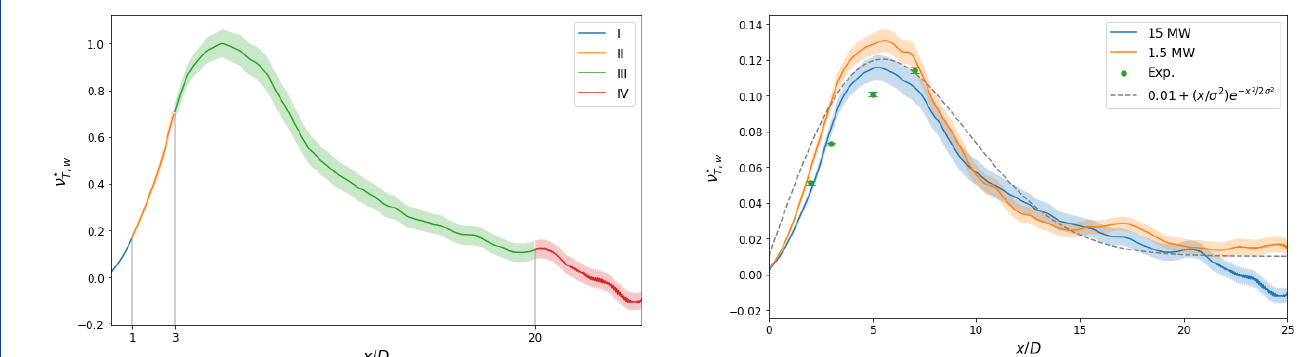
Figure 5. Normalized wake eddy viscosity for the aligned 15MW LES case. Slope fit error is represented with shading. Color denotes portions of the wake governed by similar terms in Eq. (1). Down- stream locations where driving terms transition are indicated with vertical lines.